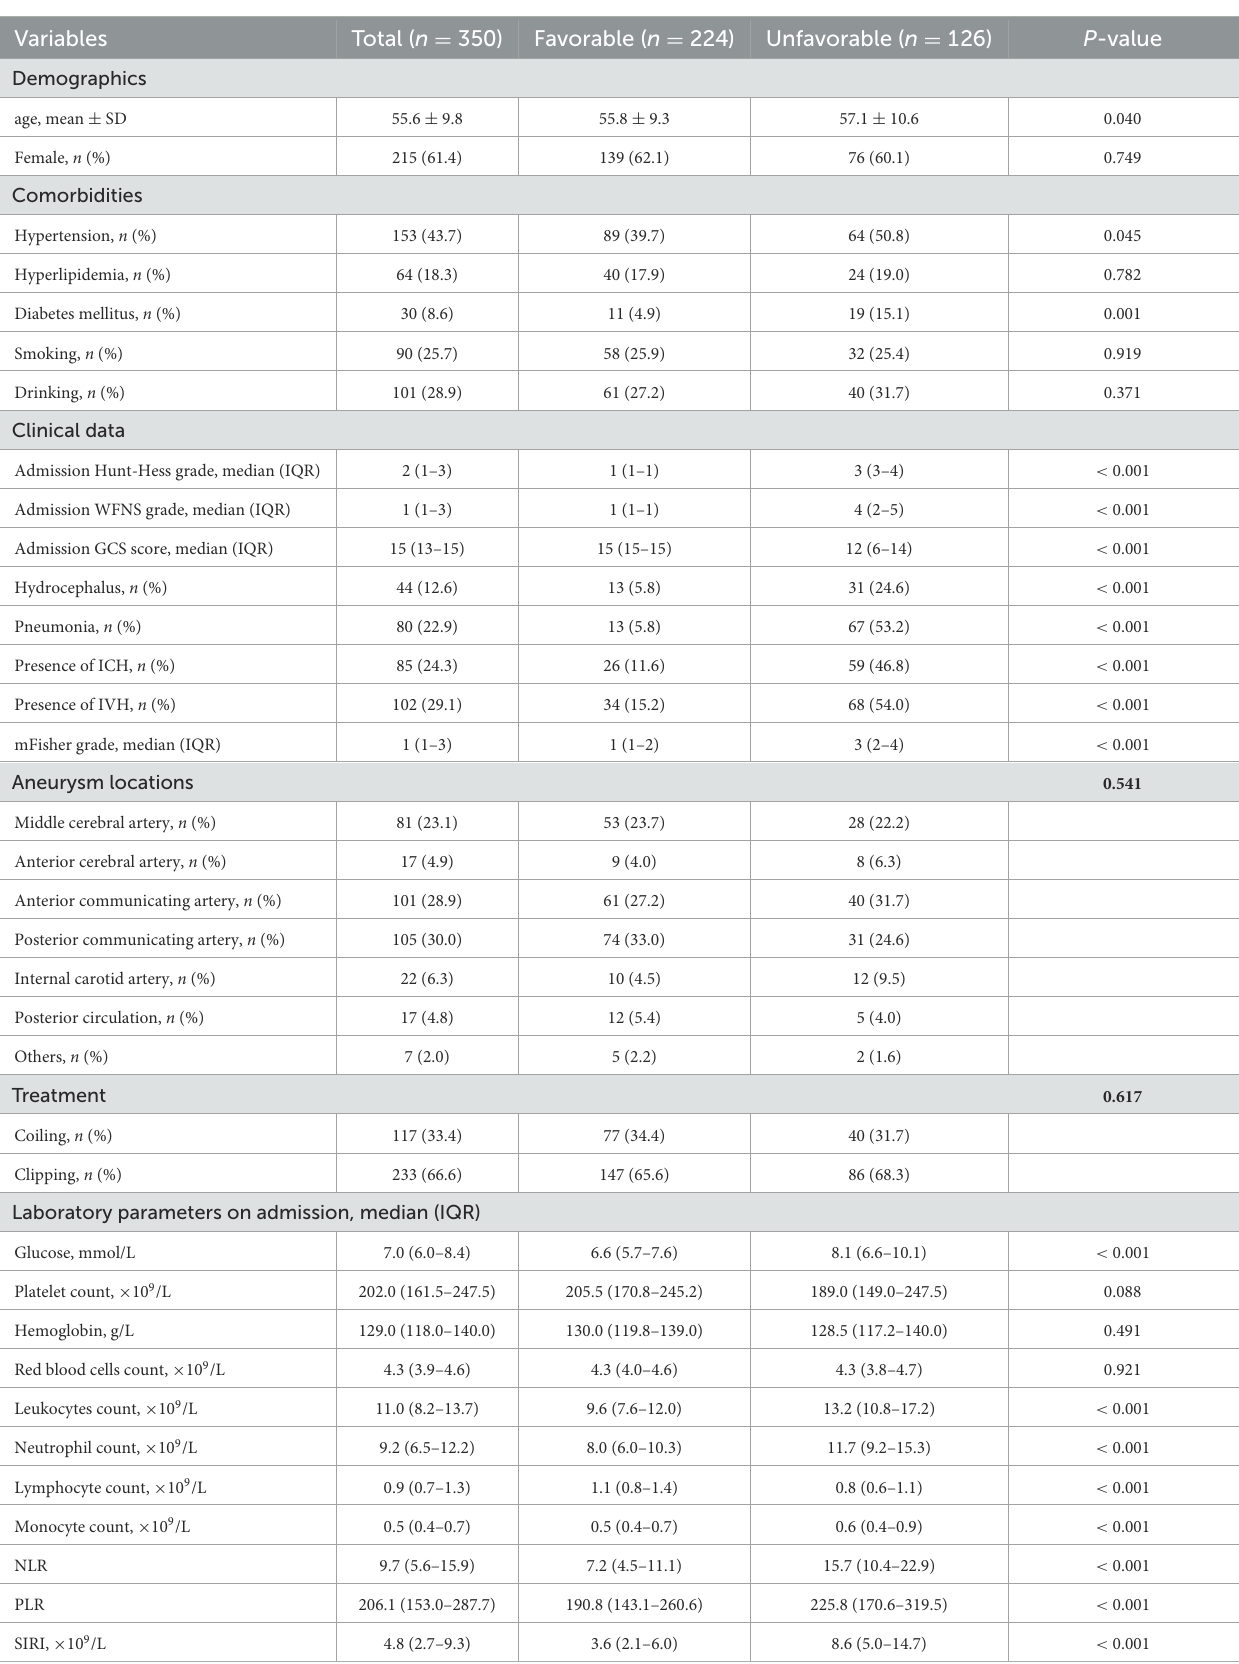
TABLE 1 Baseline characteristics of aSAH